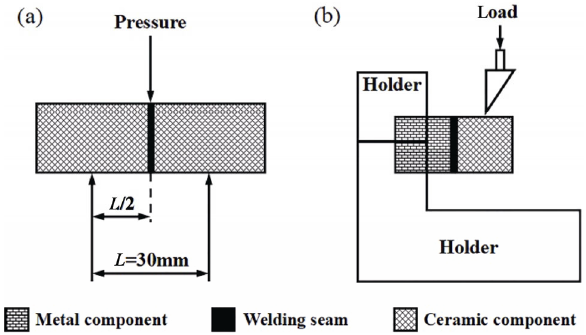
Fig. 3 Schematics of non-standard (a) bonding and (b) shear strength tests for ceramic joints. Reproduced with permission from Ref. [20], © Elsevier B.V. 2010;